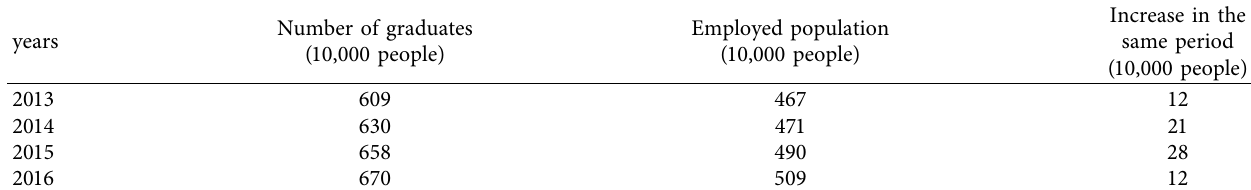
Table 1: The number of college graduates and employed persons from 2013 to 2016.